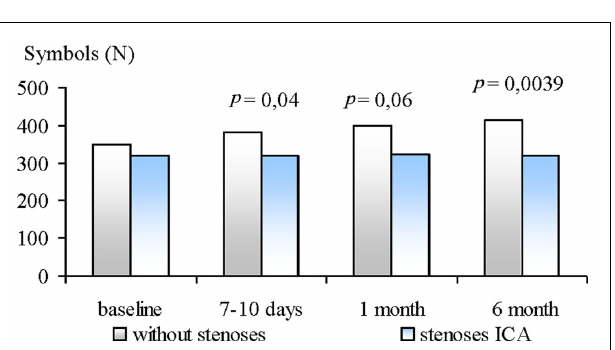
FIGURE 2 | Dynamics of number of processed Burdon’s test symbols in ICA stenoses patients and without ones at 6month follow-up after CABG.